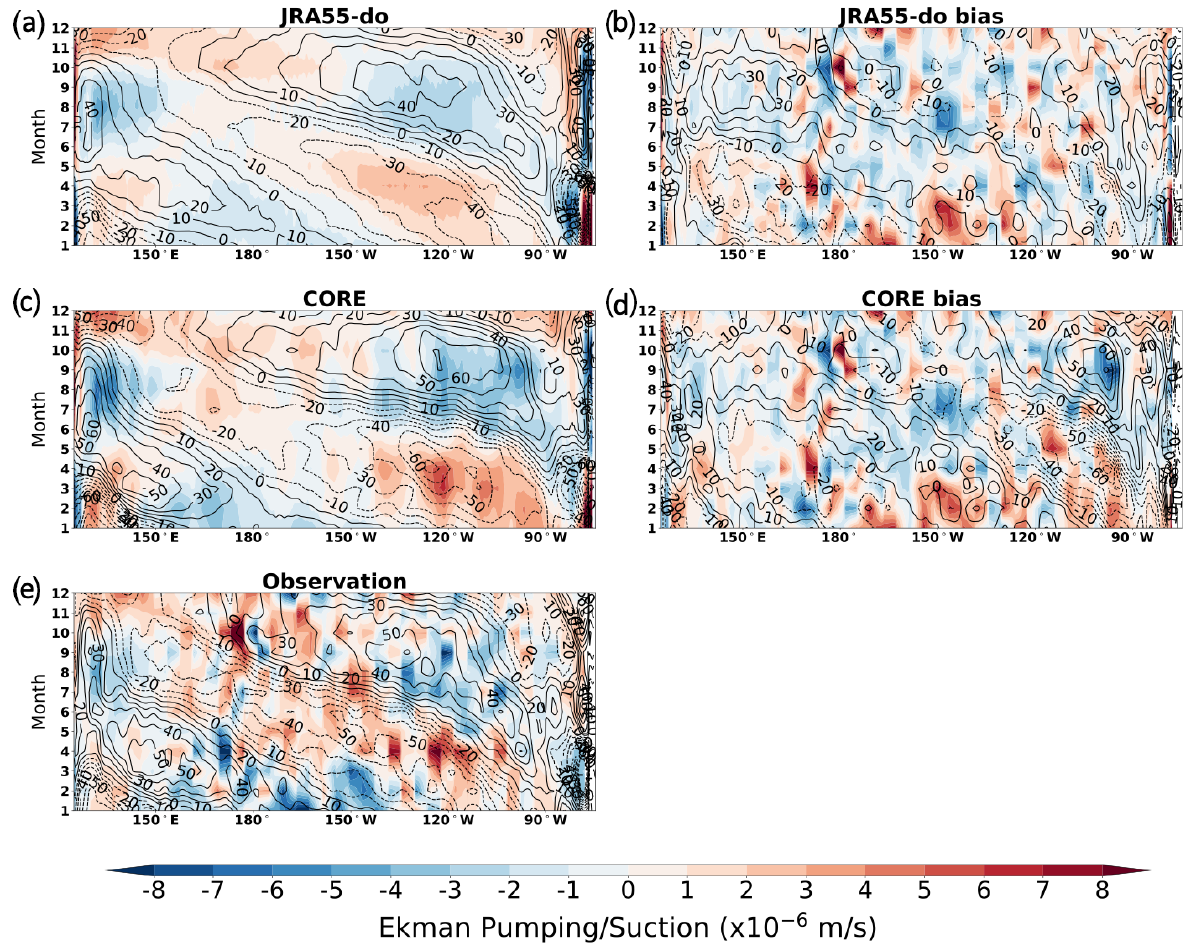
Figure 17. Hovmöller diagram of monthly climatology with mean state removed showing the meridional mean (2 to 10 ◦ N) DSL (contour in mm) and derived Ekman pumping/suction (shading) in (a) JRA55-do-forced simulation and (b) the associated bias, and in the (c) CORE- forced simulation and (d) the associated bias. (e) The DSL (contour in mm) from CMEMS and derived Ekman pumping/suction (shading) from